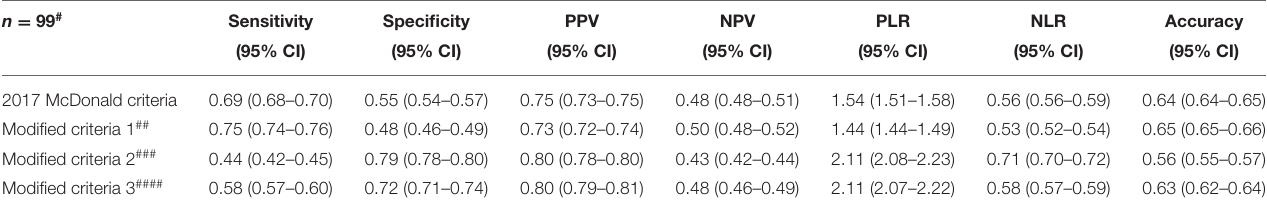
TABLE 3 | Diagnostic performance of the modified and 2017 McDonald